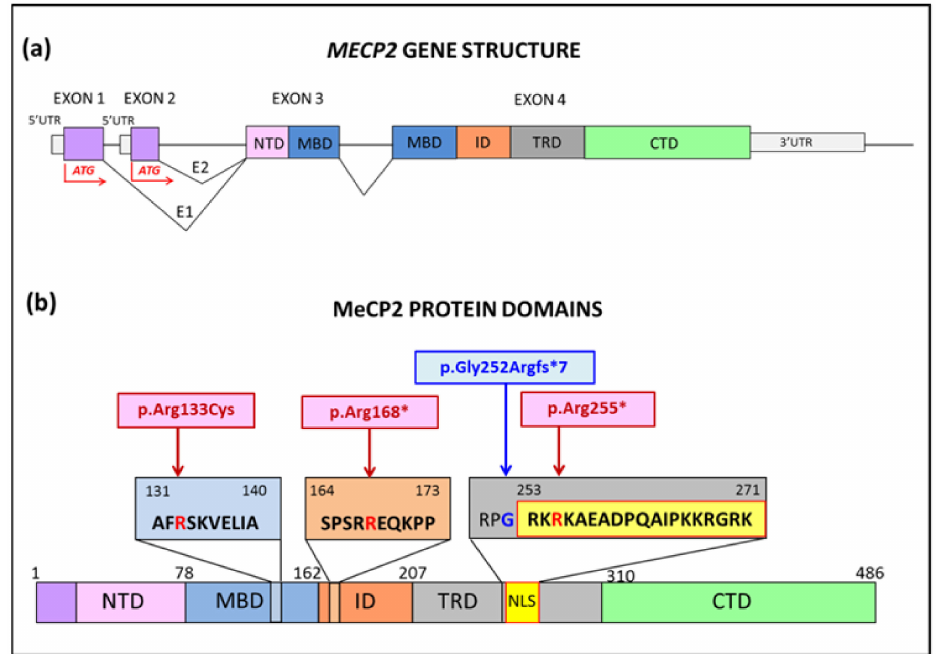
Figure 1. Representation of MECP2 gene structure and protein domains. ( a ) Schematic of MECP2 gene organization with four exons and the two isoforms (E1 and E2). ( b ) Impact of the selected hot-spot pathogenic variants on MeCP2-E2 protein isoform. NTD: N-Terminal Domain, MBD: Methyl CpG Binding Domain, ID: Intervening Domain, TRD: Transcriptional Repressor Domain, NLS: Nuclear Localization Signal, CTD: C-Terminal